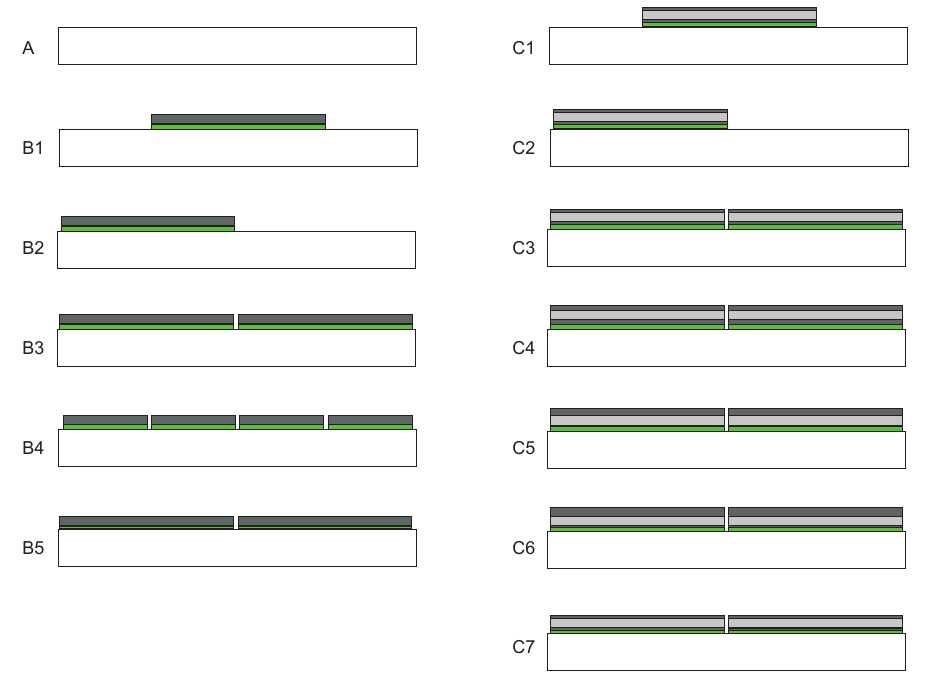
Figure 3. CLD configurations.